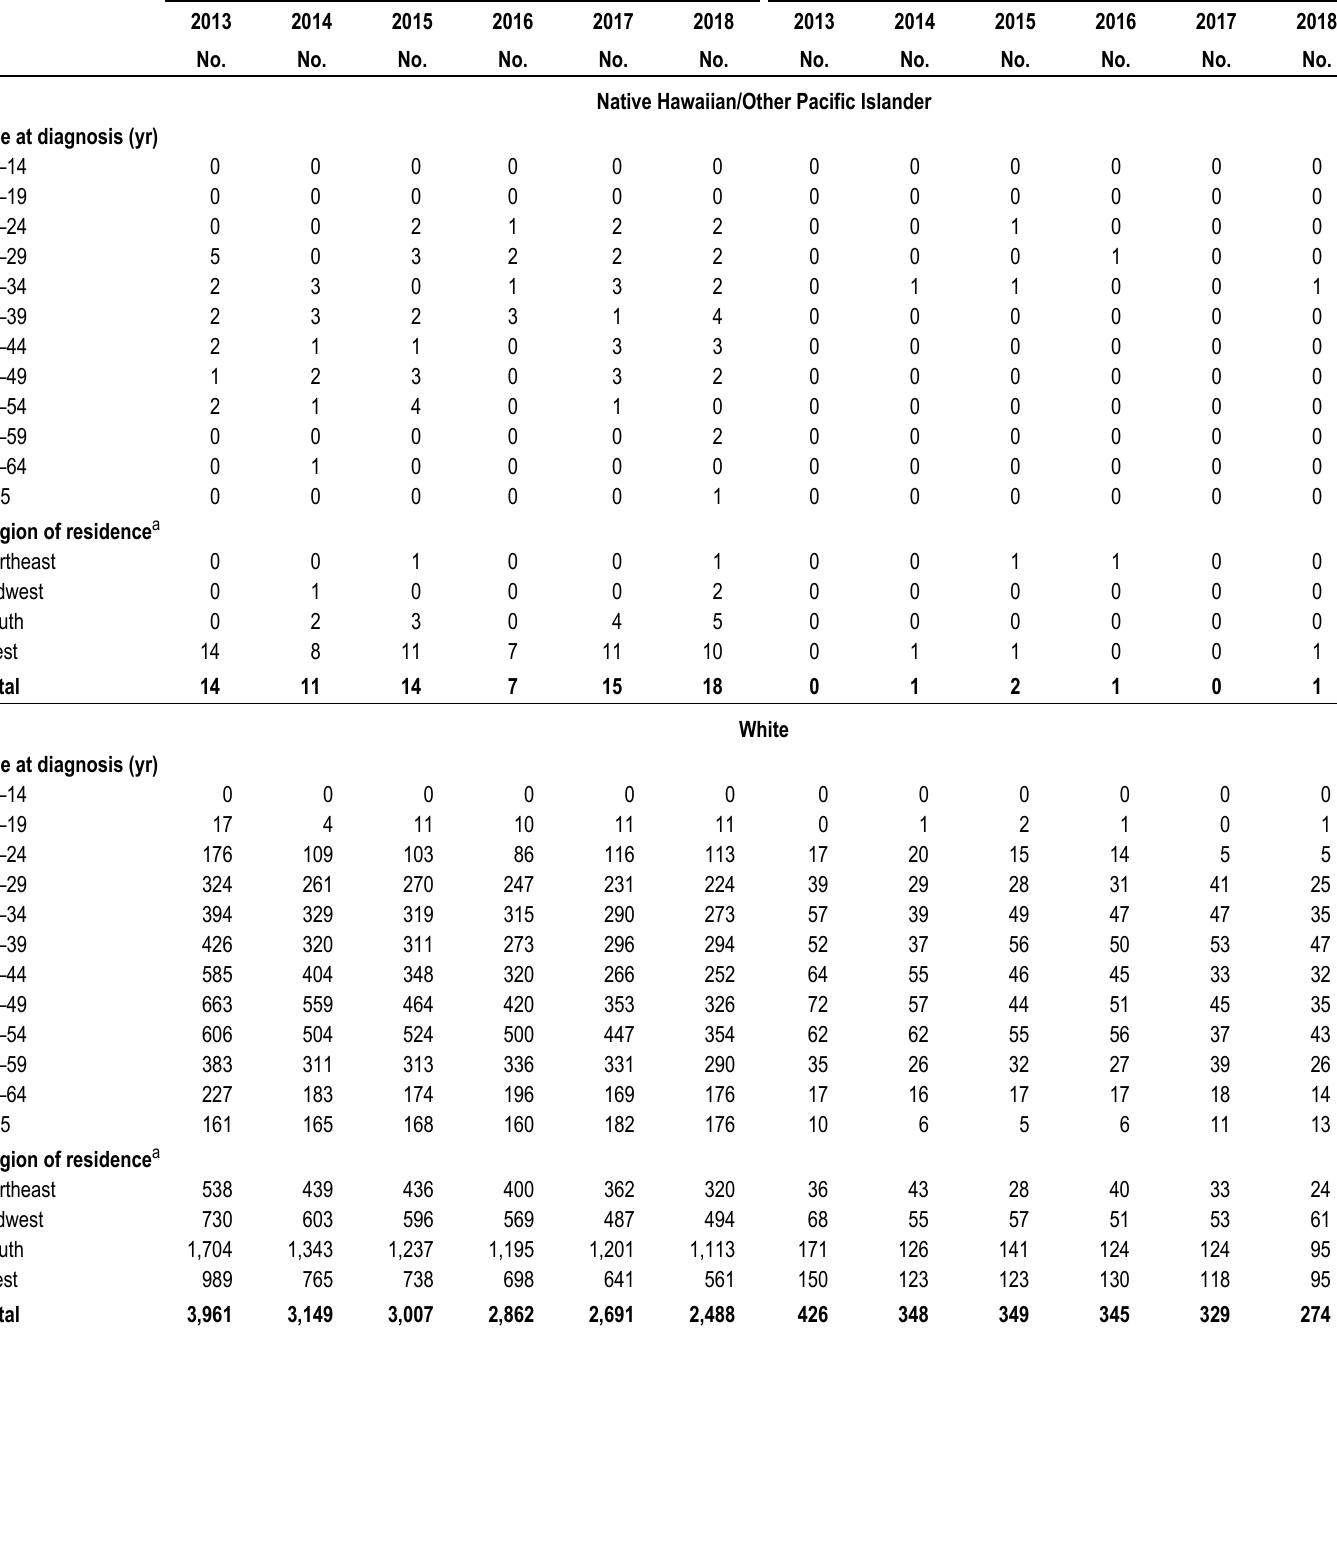
Table 10a. Stage 3 (AIDS) attributed to male-to-male sexual contact and male-to-male sexual contact and injection drug use, by selected characteristics, 2013–2018—United States (cont) Male-to-male sexual contact Male-to-male sexual contact and injection drug